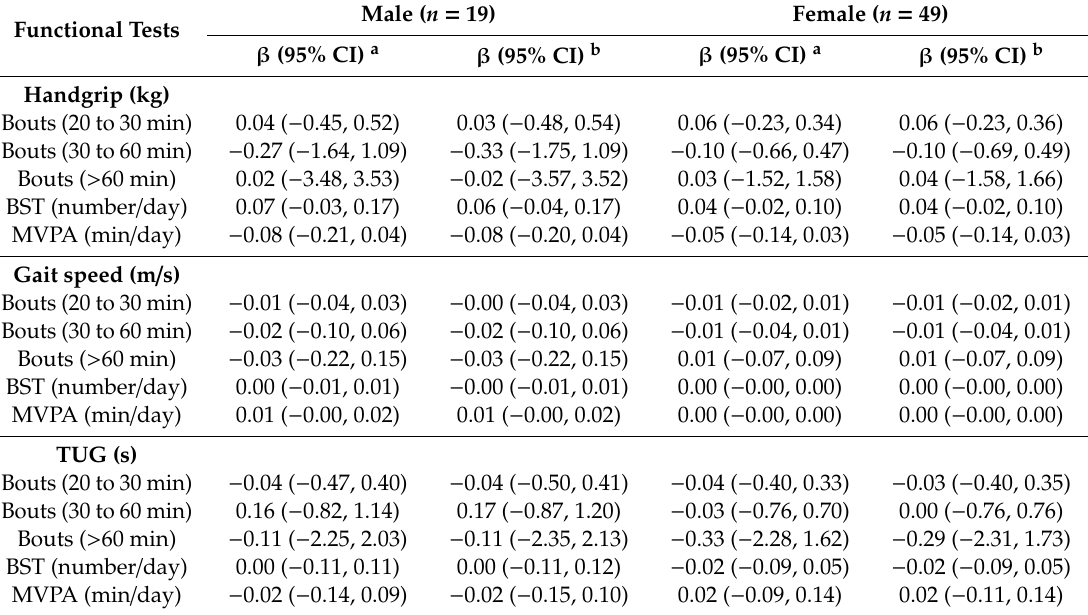
Table 5. Prospective associations of MVPA and sedentary patterns with physical function (mean changes) controlling for